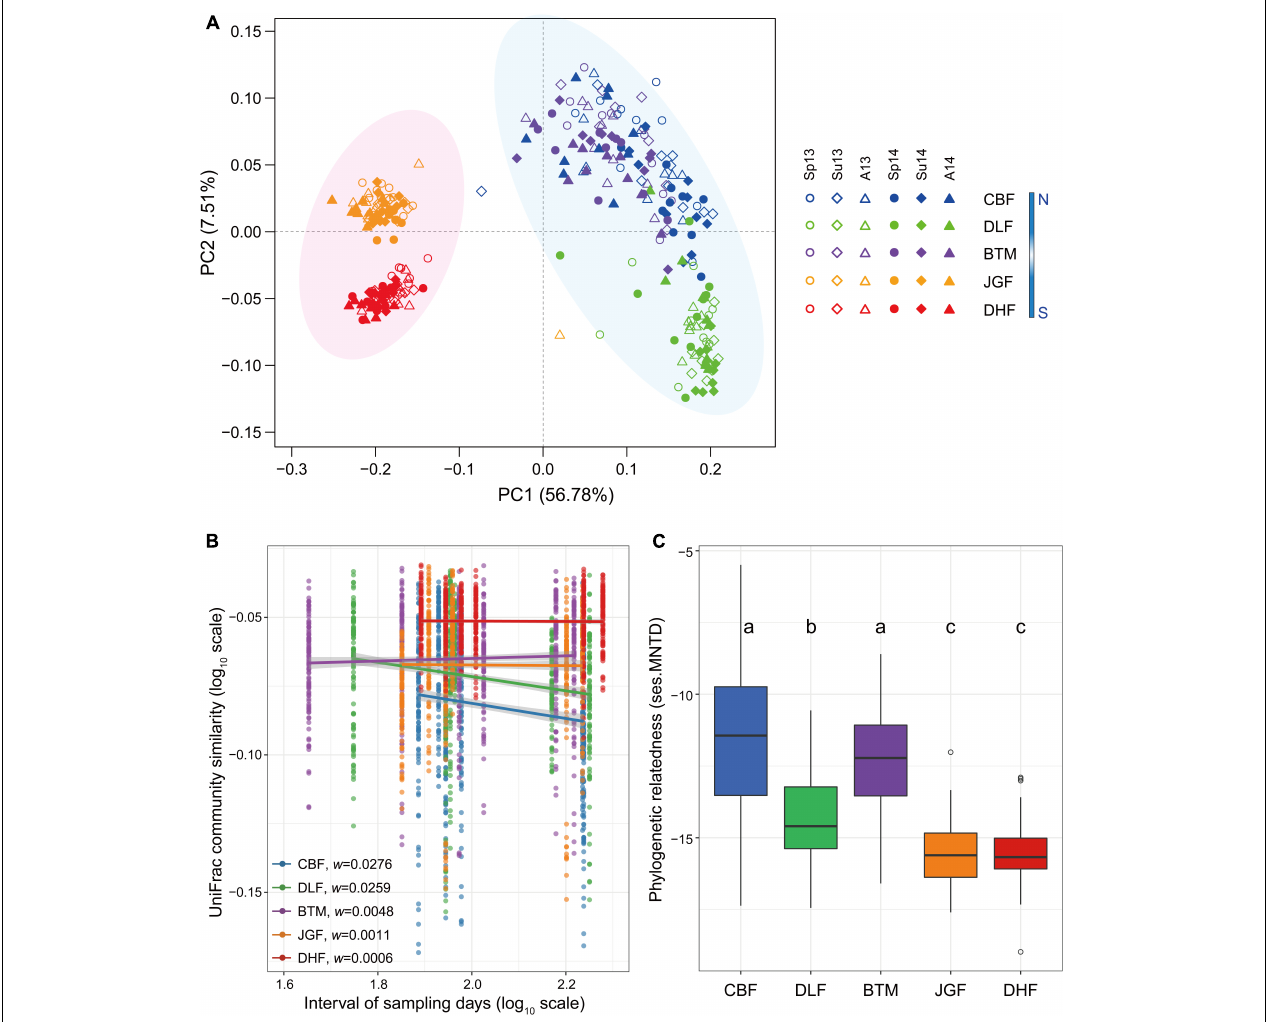
FIGURE 1 | Seasonal dynamics of microbial communities along the latitudinal forest ecosystems. Principal coordinate analysis (PCoA) plot of phylogenetic microbial community using the weighted UniFrac distance metric (A) . Microbial temporal turnover (B) and phylogenetic relatedness (ses.MNTD, (C) . The turnover rate, w (the regression slope), was estimated using a linear regression (log–log space approach) fit between the pairwise average similarity values and intervals of sampling time at seasonal temporal scales across latitudinal forest ecosystems. The slopes of all lines were significantly different from zero and significantly different for pairwise comparison. Solid lines indicate the predicted relationships are significant ( P < 0.05) based on linear regression estimated using ordinary least squares. Linear relationships at different latitudinal forests are indicated by color, and the shaded region represents the 95% confidence limits on the regression estimates. The standardized effect sizes of MNTD (ses.MNTD) values were all significantly negative ( P = 0.001). Pairwise comparison was performed between latitudinal samples. Different letters (a, b, c) indicate a significant difference ( P < 0.05) by ANOVA analysis. Forests along a latitudinal gradient from north to south include Changbai Forest (CBF), Dongling Forest (DLF), Baotianman Forest (BTM), Jinggang Forest (JGF), and Dinghu Forest (DHF). N, northern sites; S, southern sites. Samples were coded by sampling season and year. Sp, spring; Su, summer; A, autumn. The number 13 and 14 represents Year 2013 and 2014,